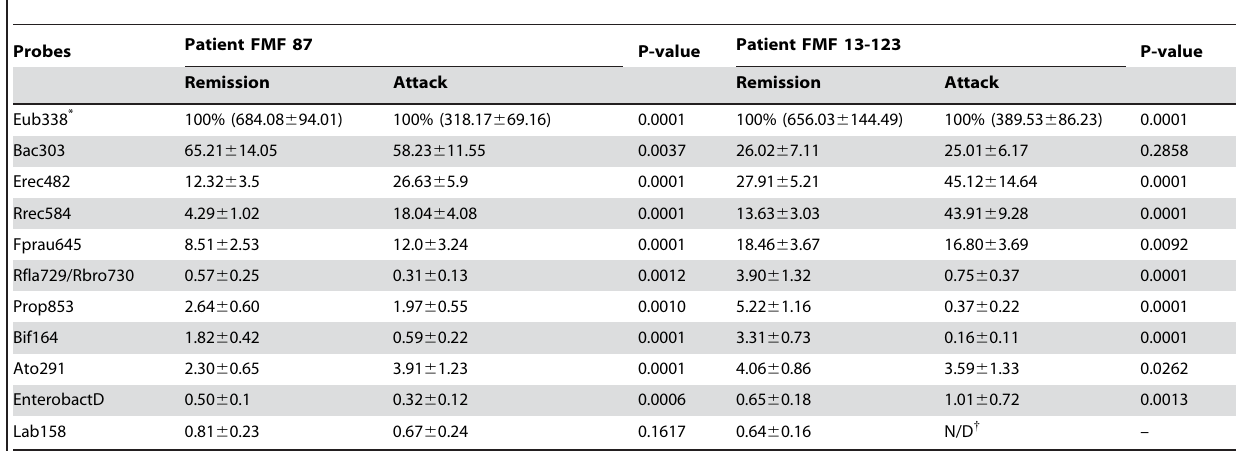
Table 6. Distribution of main bacterial groups in two FMF patients in remission and